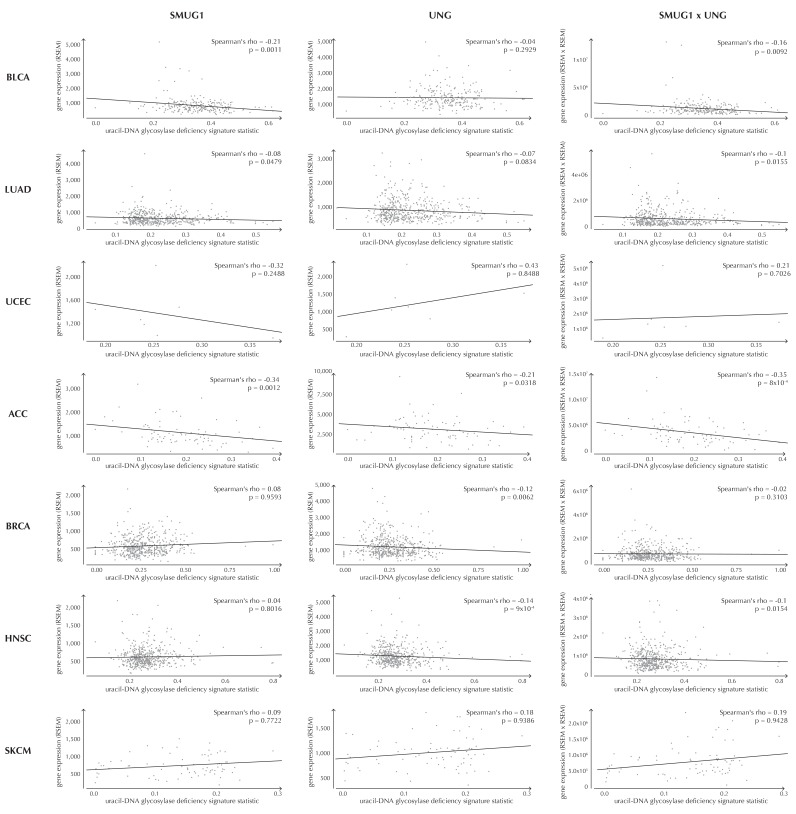
Examples of correlation between the uracil-DNA glycosylase deficiency signature statistic and SMUG1 gene expression (first column), UNG gene expression (second column) and the product of SMUG1 and UNG gene expression (third column) using TCGA exome data for seven different cancer types (rows).The correlation is assessed using one-sided Spearman’s correlation tests. For some cancer types, the correlation coefficients are positive, although these cases are not significant and generally based on few samples.